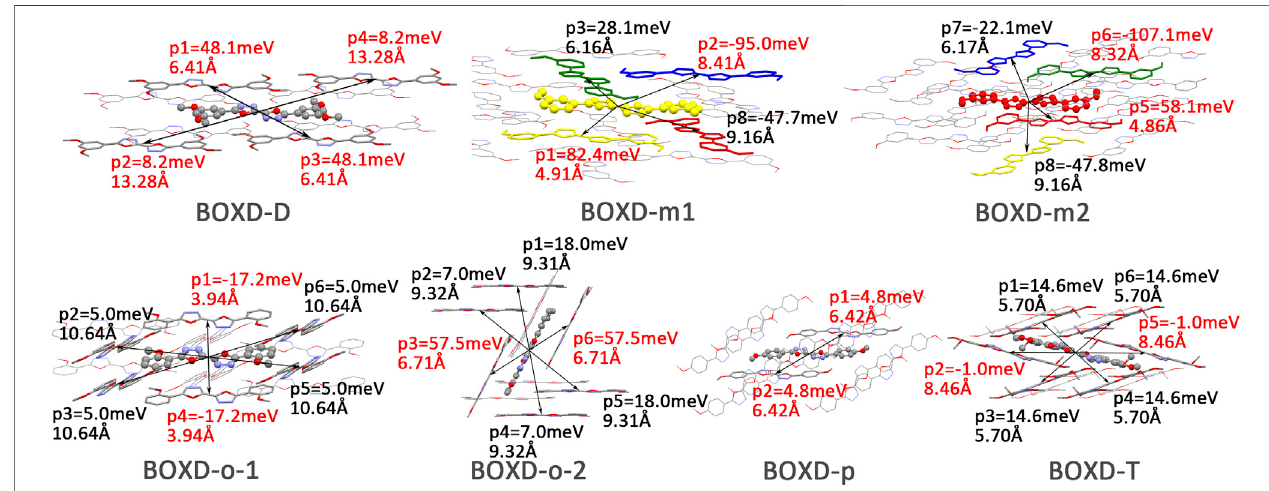
FIGURE 10 | Transfer integral and intermolecular distance of primary hole transfer paths in each crystal structure. BOXD-m1 and BOXD-m2 need to be distinguished due to the complexity of intermolecular position, and the molecular color is based on Figure 1 . The transfer integral and intermolecular distance of π stacking are depicted in red, and herringbone arrangement are depicted in black.